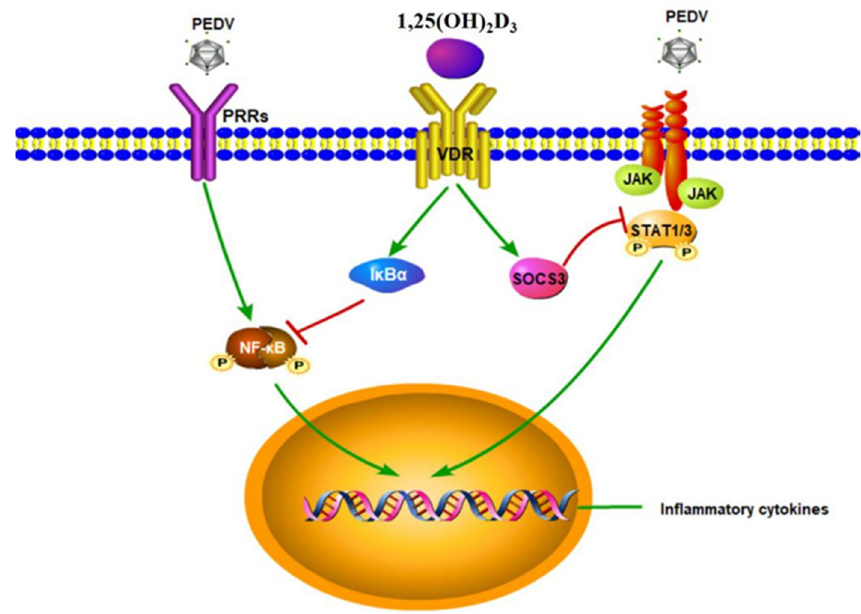
Figure 10. The potential mechanism of 1,25(OH) 2 D 3 in inhibiting inflammatory cytokine expression induced by PEDV in IPEC-J2 cells. In this study, 1,25(OH) 2 D 3 attenuated PEDV-induced inflammatory cytokine expression via suppressing the NF/ κ B and JAK/STAT signaling pathways.